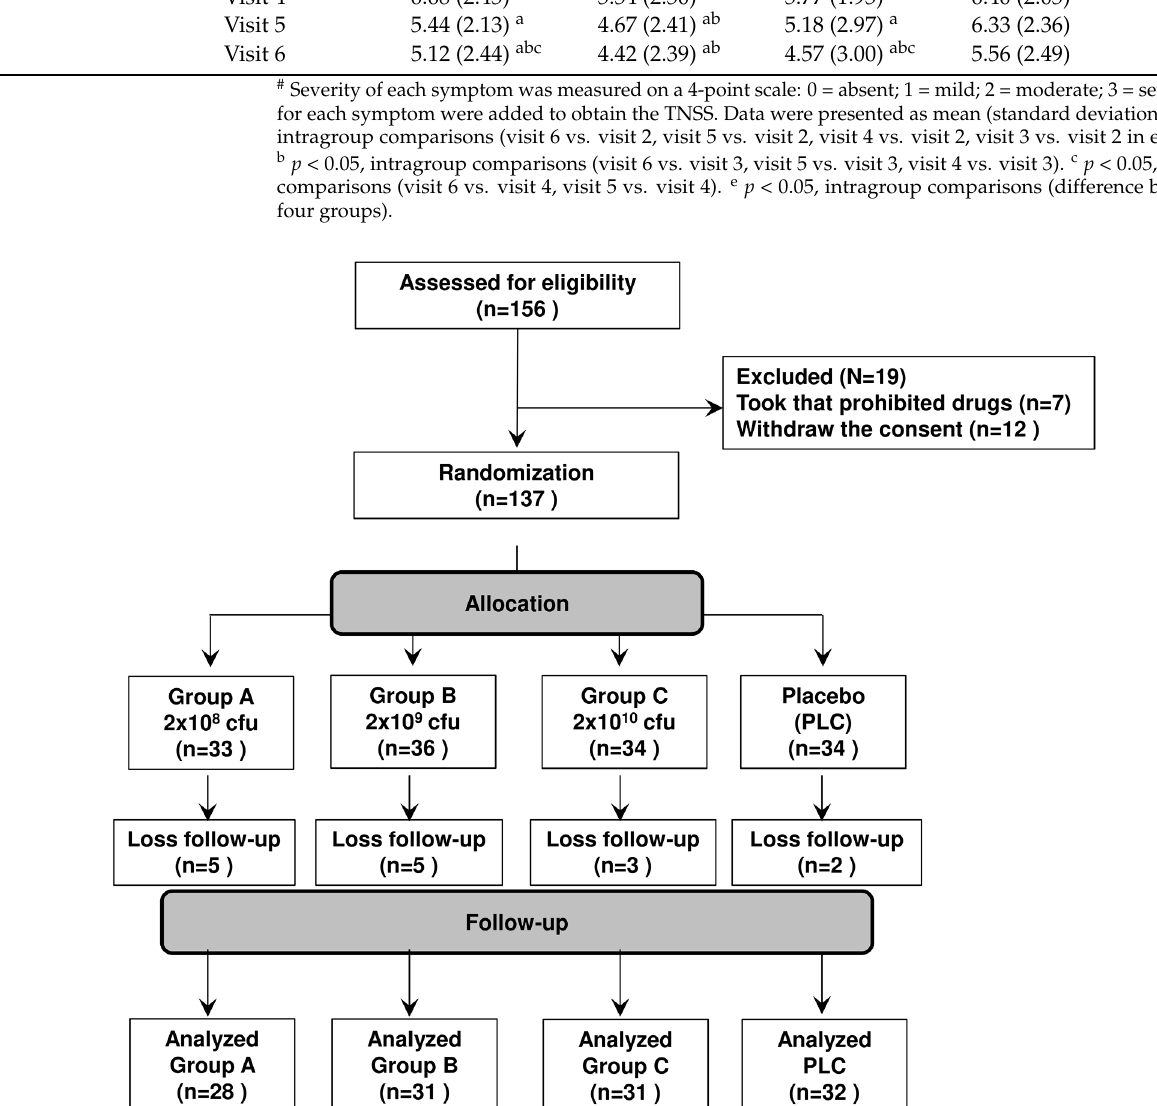
Figure 7. Enrollment of children with AR in our double-blind, randomized, placebo-controlled trial. The inclusion and exclusion criteria are described in the Section 2.